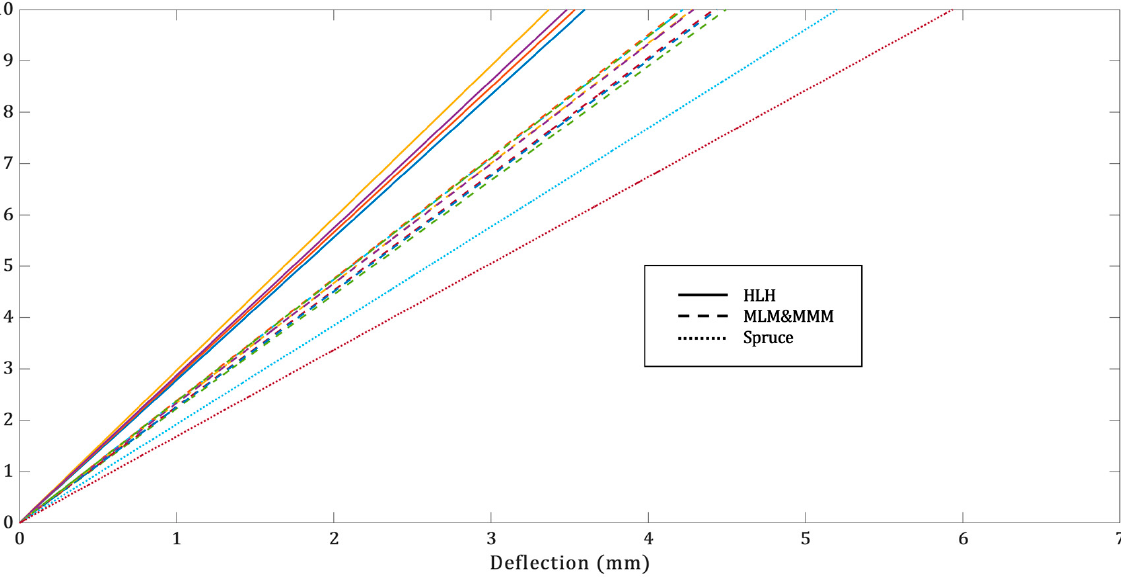
Figure 3. Load–deflection curves. Table 4. Experimental and theoretical bending stiffnesses.